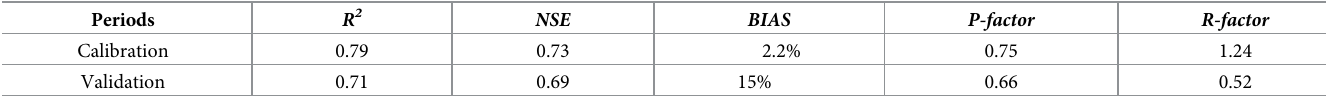
Table 4. Results of the SWAT model evaluation indicators in the Yanhe River Basin. Periods